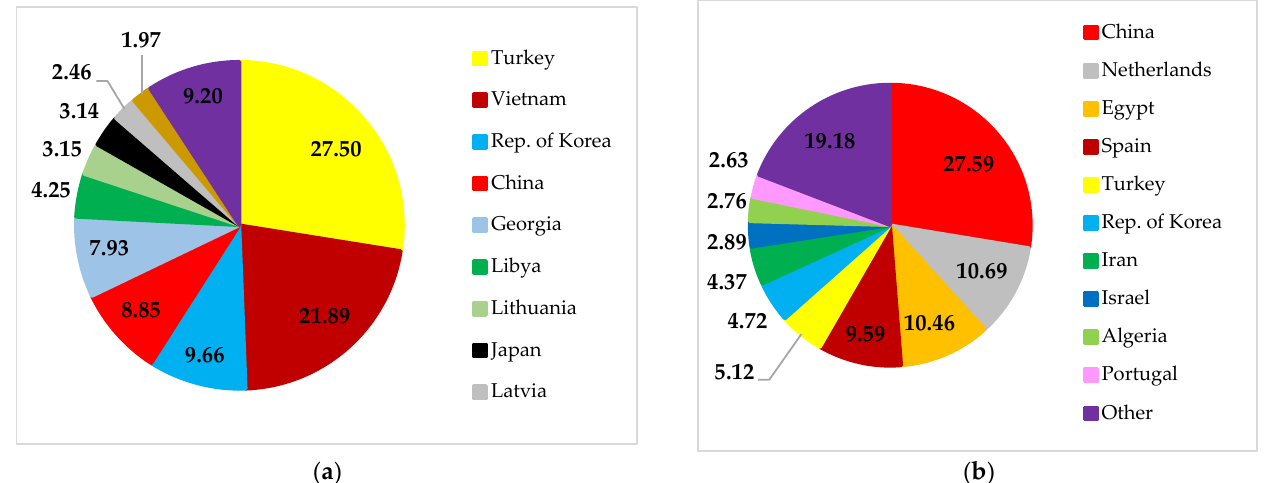
Figure 13. Destinations for Russian ( a ) and Ukrainian ( b ) maize exports. Source: [30]. We selected China, Turkey, and Korea as samples to highlight the vital role of Ukraine and Russia in the world maize trade (Figure 14). Ukraine supplies 55.55%, 30.73%, and 12.39% of maize imports to China, Turkey, and the Republic of Korea, respectively. Meanwhile, Russia is the leading supplier of Turkey’s import needs (32.43%). Russia’s role was smaller in meeting the import needs of the Republic of Korea (2.07%) and China (1.22%). The conflict between Ukraine and Russia has disrupted the distribution of maize to China, Turkey, and the Republic of Korea and has the potential to cause food shortages in these countries.